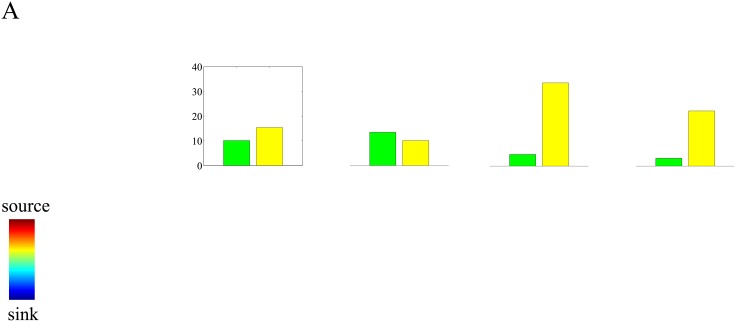
Limitations of the two-dimensional CSD method.Bar plots of the average reconstruction errors for the (numerical) CSD method (yellow) and the MNE inverse method (green) and under each of the four CSD configurations. Errors were obtained by averaging over 500 independent realizations.